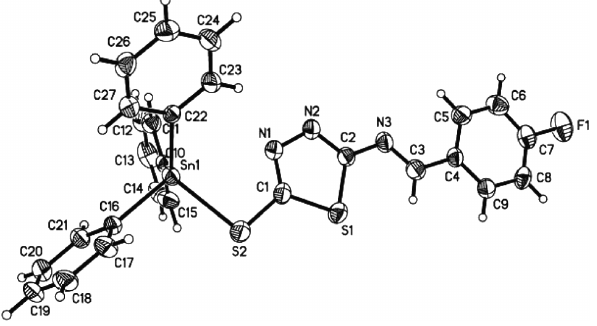
Table 1: Data collection and handling.